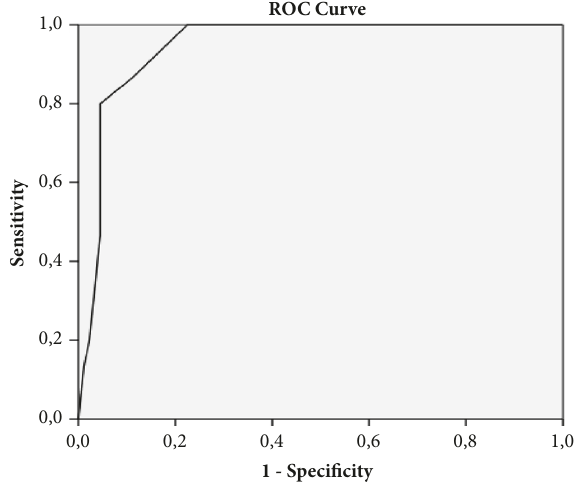
Figure 1: ROC (receiver-operating characteristic) curve in predict- ing the optimum inter-arm systolic blood pressure difference cut-off value for predicting high SYNTAX